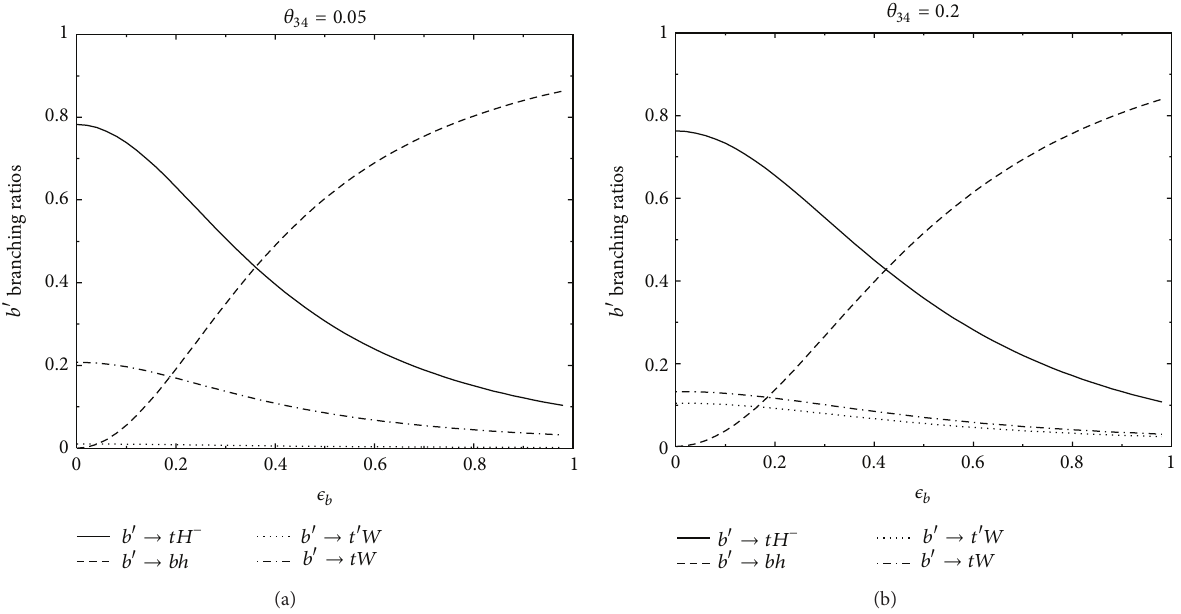
Figure 17: The branching ratios for the 𝑏 󸀠 decay channels 𝑏 󸀠 → 𝑡𝐻 + , 𝑏 󸀠 → 𝑏ℎ , 𝑏 󸀠 → 𝑡𝑊 , and 𝑏 󸀠 → 𝑡 󸀠 𝑊 in the 4G2HDMI, as a function of 𝜖 𝑏 for 𝑚 ℎ = 125 GeV, 𝑚 𝑏 󸀠 = 500 GeV, 𝑚 𝑡 󸀠 = 400 GeV, 𝑚 𝐻 + = 300 GeV, tan 𝛽 = 1 , 𝜖 𝑡 = 𝑚 𝑡 /𝑚 𝑡 󸀠 , and 𝜃 34 = 0.05 (a) and 𝜃 34 = 0.2 (b). Also, > 𝑚 𝛼 = 𝜋/2 and 𝑚 𝐴 𝑏 󸀠 are